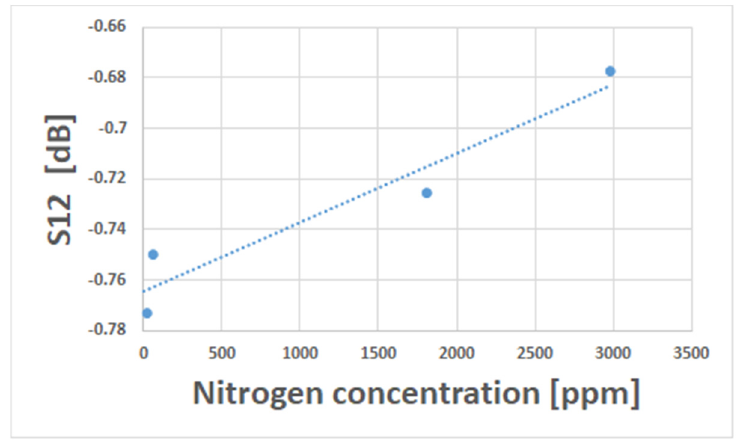
Figure 11. Master diamonds S12 magnitude vs. the estimated nitrogen concentration at a frequency of 17.72 GHz.